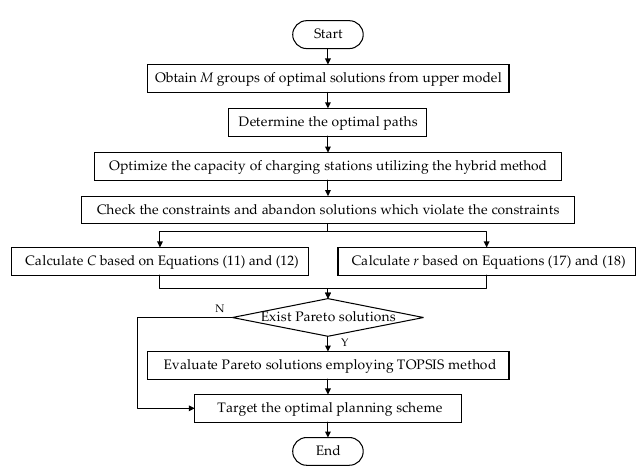
Figure 10. The flowchart of the lower model.